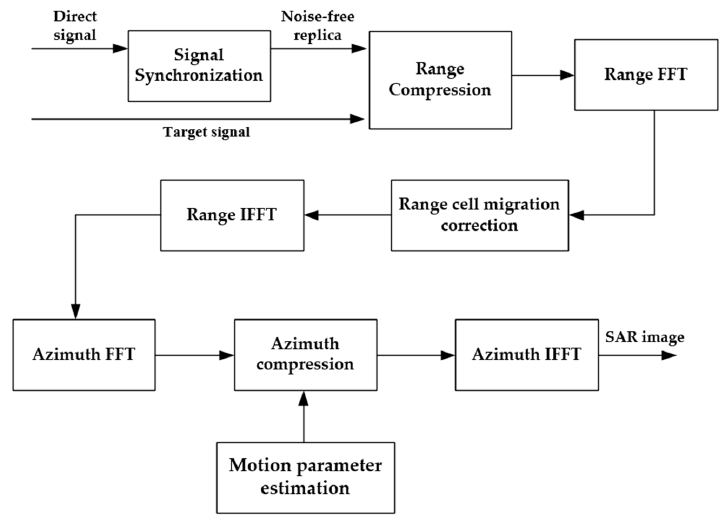
Figure 5. Block diagram of the proposed moving target image formation algorithm.